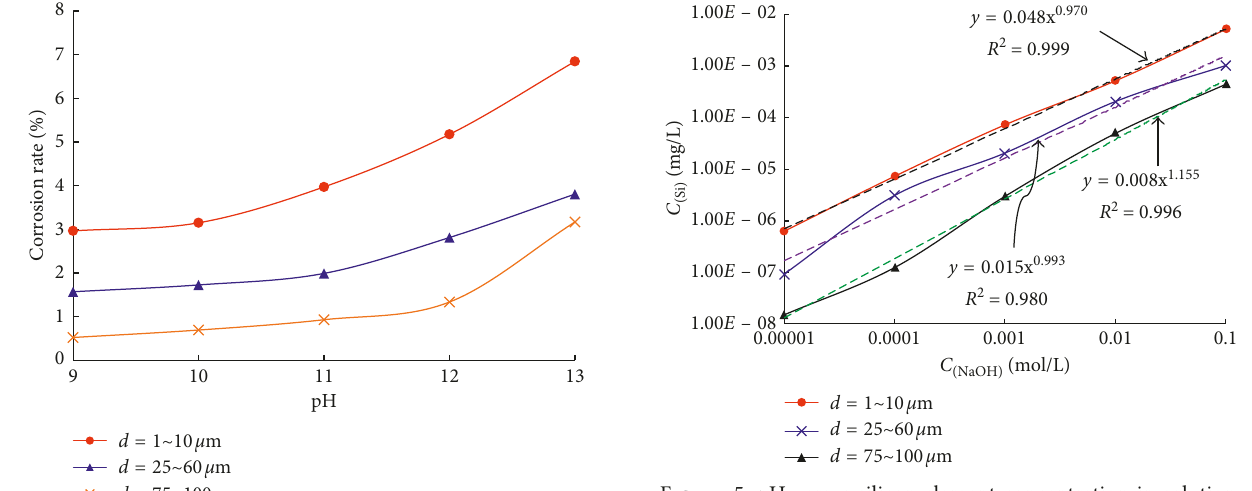
Figure 5: pH versus silicon element concentration in solution.